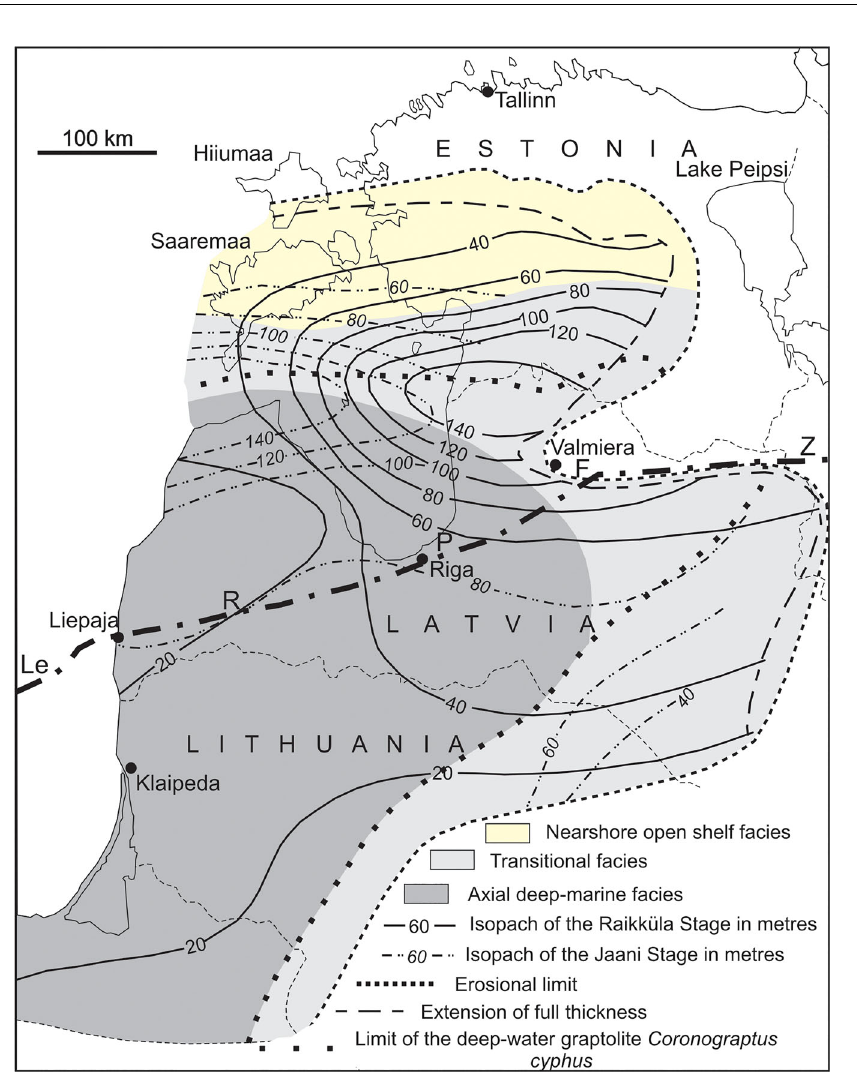
Fig. 12. The Baltic Basin facies/thickness distribution with the Livonian Tongue in Aeronian (Raikküla) time and locations of the early Silurian Raikküla and Jaani depressions on the Scandinavian side of the LeRPFZ (modified after Kaljo & Jürgenson